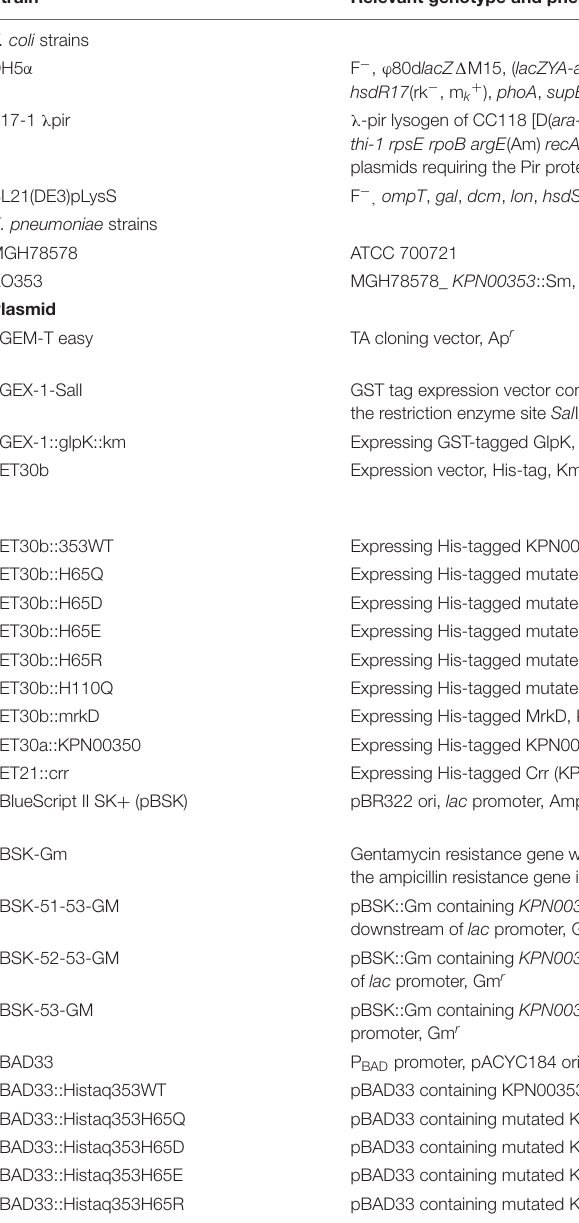
TABLE 1 | List of strains and plasmids used in the experiments. Strain Relevant genotype and